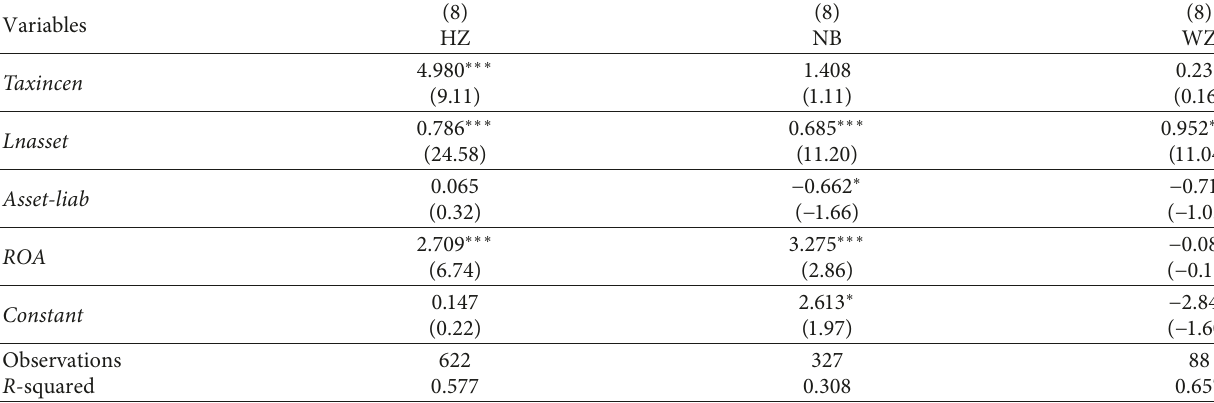
Table 8: Tax incentive policies-innovation input (district)